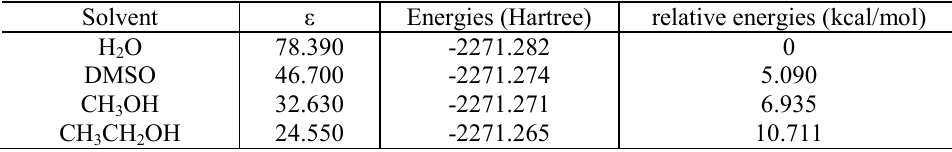
Table 3. Energies (Hartree) and Relative Energies (kcal/mol) for V Isomer at the BLYP/6- 311++G** level in Different